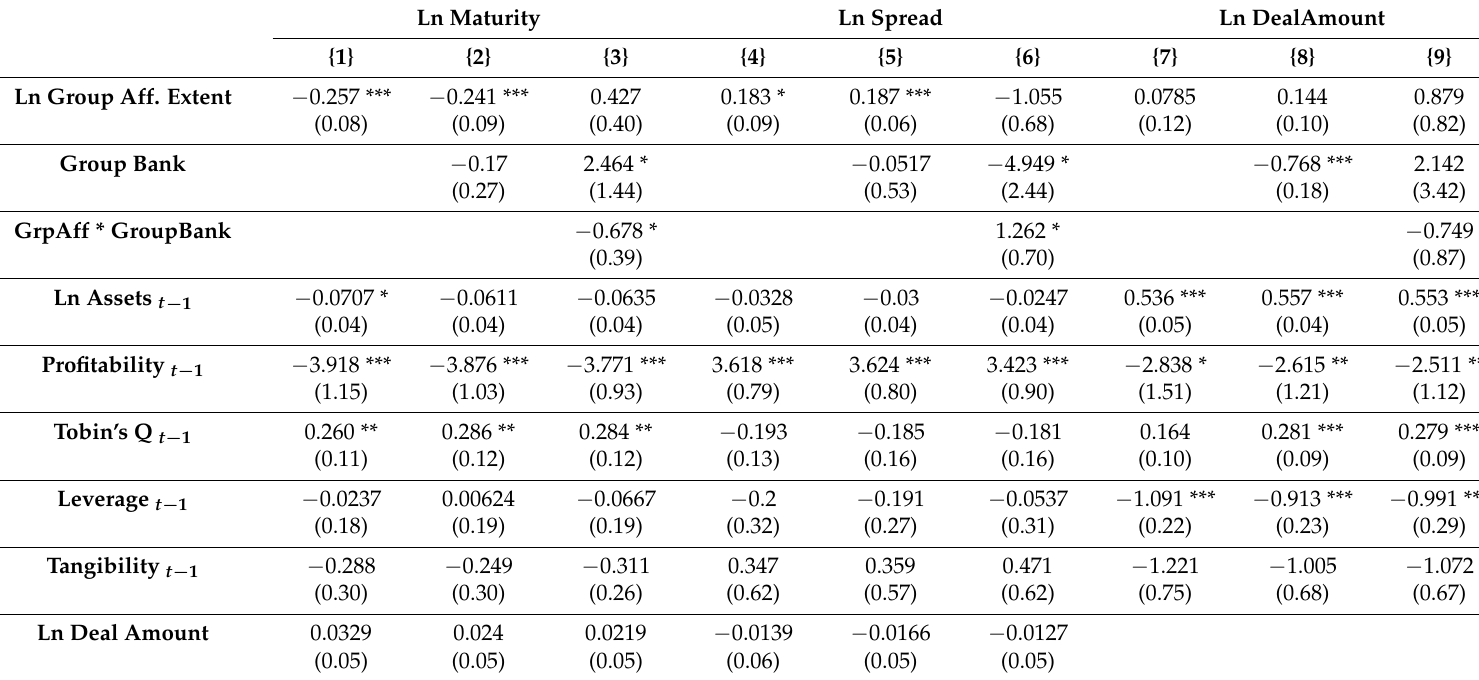
Table 7. OLS regressions of Cost of Loans on Group Affiliation Extent, Group Bank, and Borrower and Loan Characteristics. Table 7 presents the pooled ordinary least squares (OLS) regression results of ln (Maturity), ln (Spread), and ln (DealAmount) on Group Affiliation Extent, Group Bank, interaction terms, and Borrower and Loan Characteristics. Group Affiliation Extent is calculated based on the percentage of group ownership in borrower firms (0% indicates that there is no group association, and 100% means that the associated group owns all the firm’s shares). Control variables include firm and loan characteristics, and loan type, year, and industry dummies. Robust standard errors are reported in parentheses. Each model is clustered at the group level to control for possible group fixed effects. *, **, and *** represent significance levels of 10%, 5%, and 1%